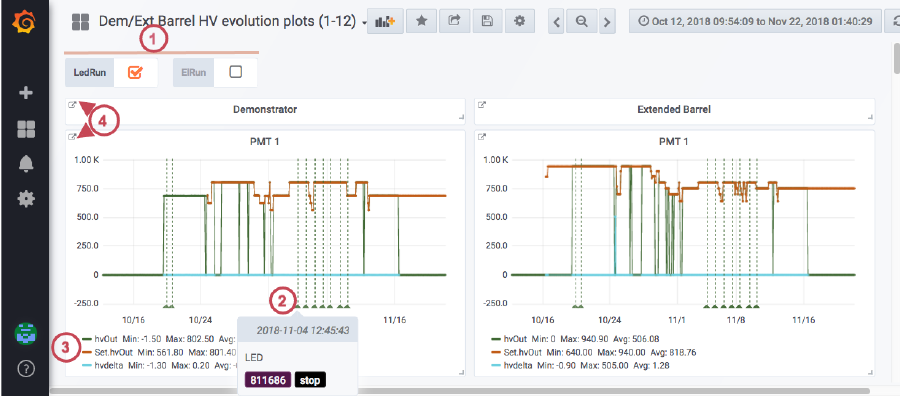
Fig. 3. Demonstrator vs. Extended Barrel